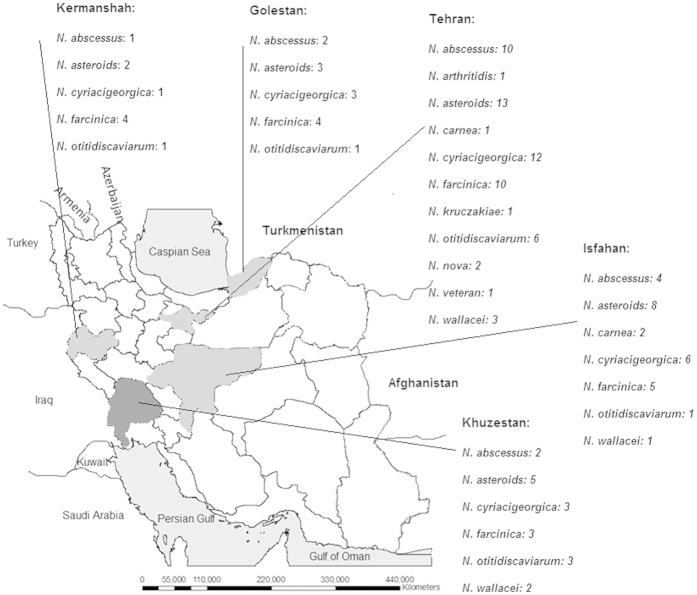
Geographic distribution of clinical isolates of Nocardia collected in the study.The figure was generated by AutoCAD MAP 3D“Autodesk® AutoCAD® Map 3D (http://www.autodesk.co.uk/products/autocad-map-3d/overview)” and then finalized by Photoshop CS5 software.